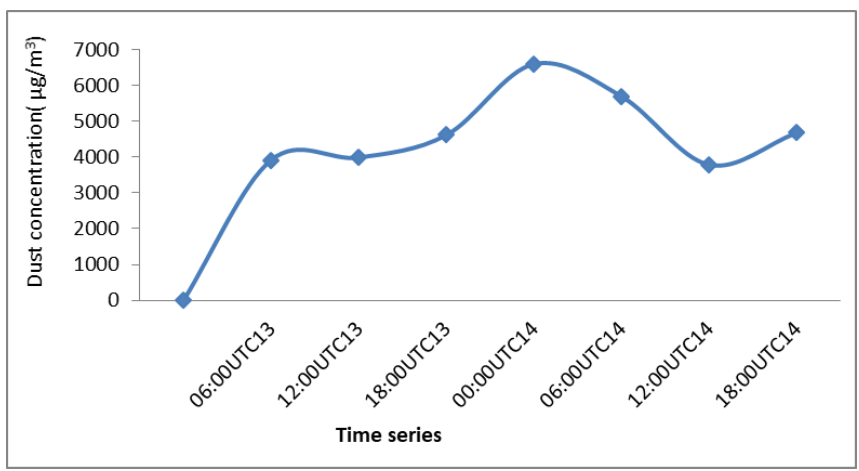
Figure 18. Surface dust concentration series (µg/m 3 ) simulated with GOCART scheme for 14 February 2018.